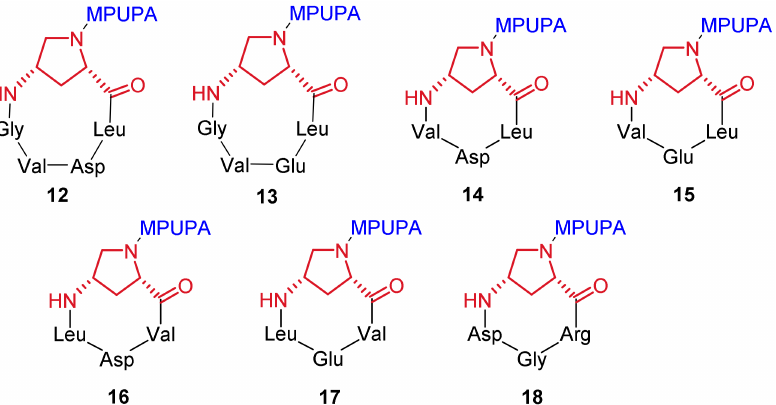
Figure 7. The collection of Amp-MPUPA-bearing cyclopeptidomimetics 12 – 18 designed and synthe- sized in this